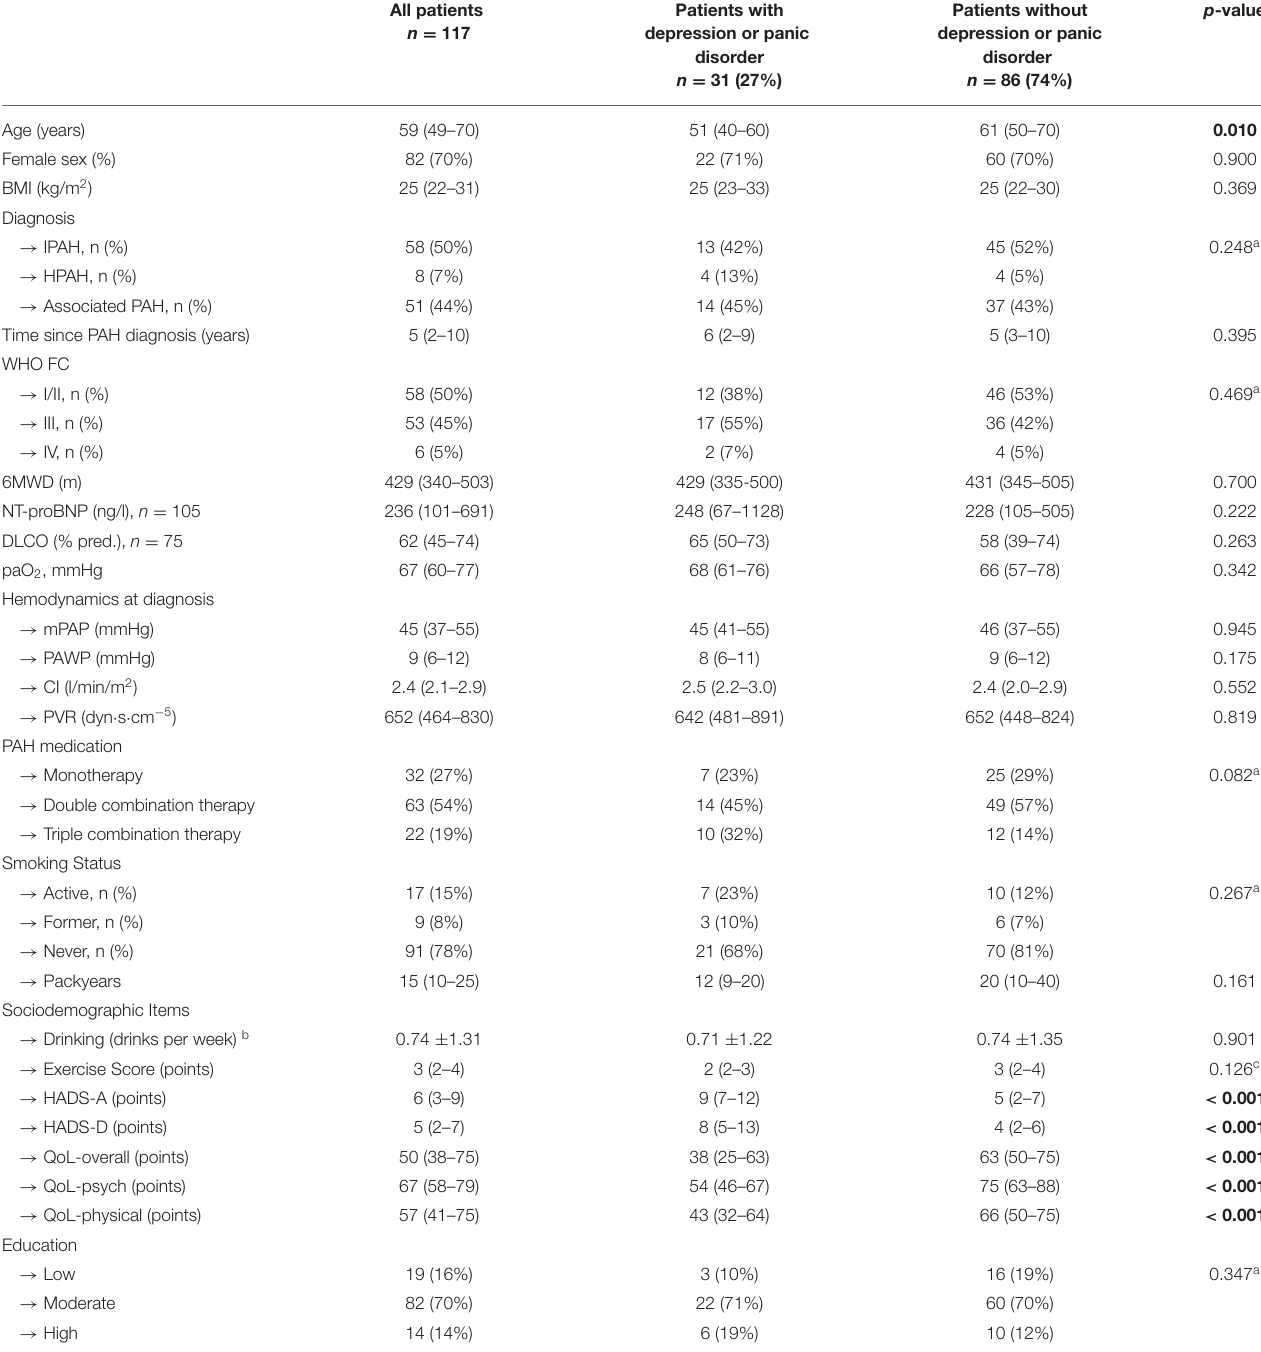
TABLE 1 | Characteristics of the patients at baseline.